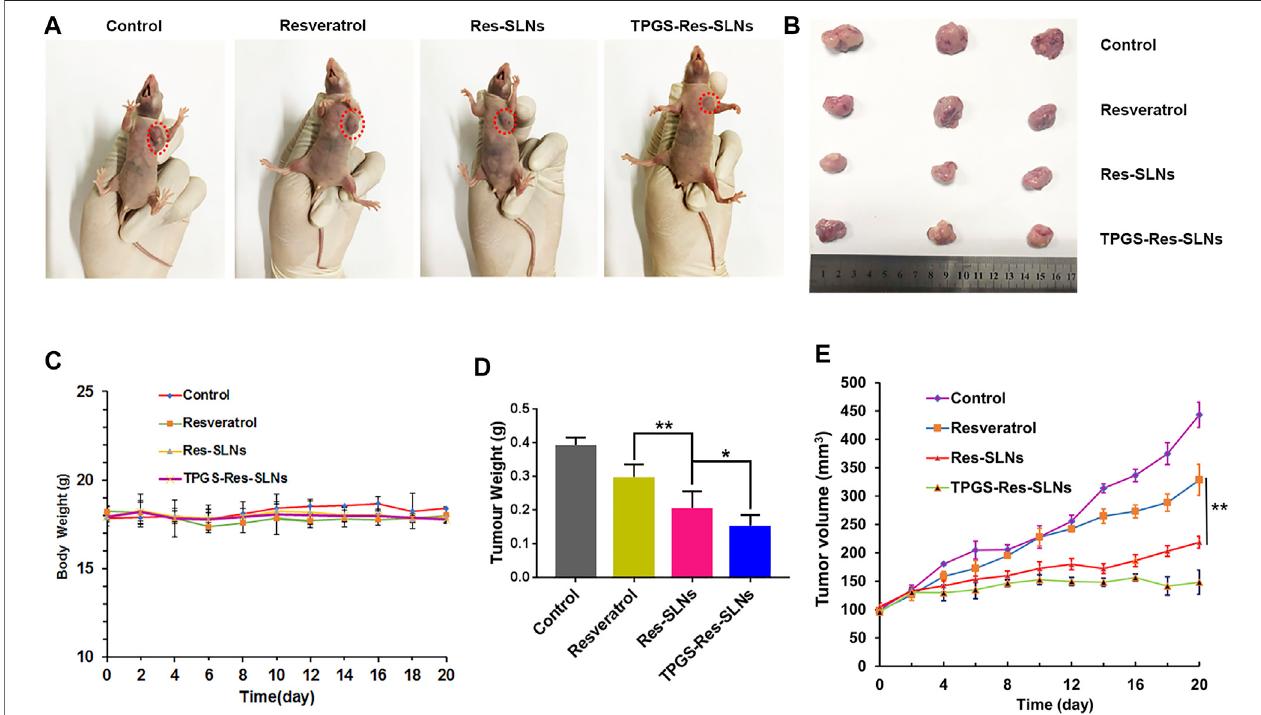
FIGURE7| The invivo ef fi caciesofResveratrol,Res-SLNsandTPGS-Res-SLNsonmicebearingSKBR3/PRxenografts. (A) Representativeimagesofmiceatthe 16th day in the different treatment groups. (B) Digital images of tumors excised from representative mice after the indicated treatments. (C) Body weight vs. time curves for mice treated with the indicated formulations. (D) Tumor weight of mice in the different treatment groups. (E) Tumor volume vs. time curves for mice treated with the indicated formulations. he data represented mean ± SD ( n (cid:1) 4). * p < 0.05, ** p <